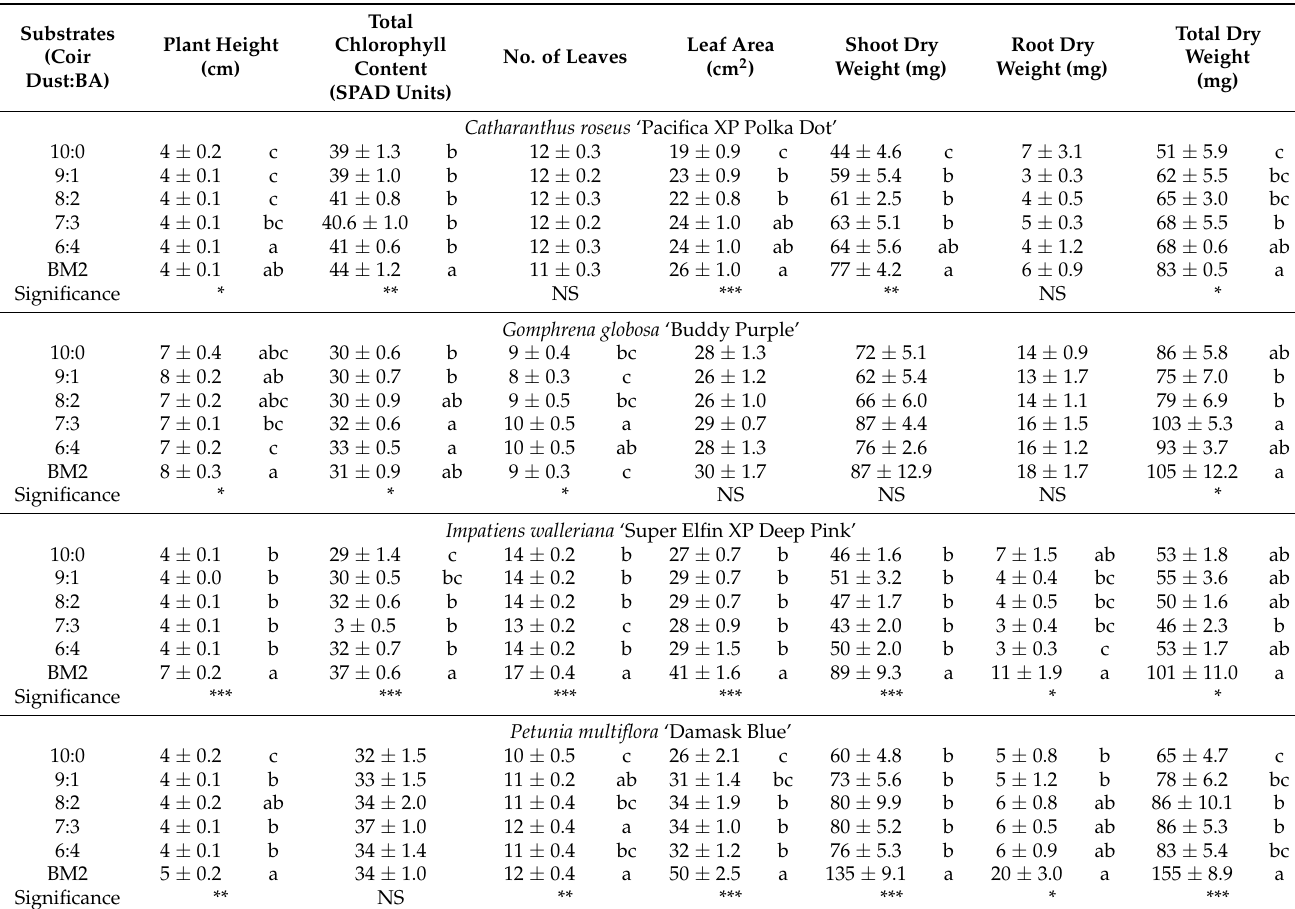
Table 4. The growth parameters of the four bedding plants grown for 7 weeks in mixed coir dust and coal bottom ash (BA) substrates and in a commercial germinating mixture